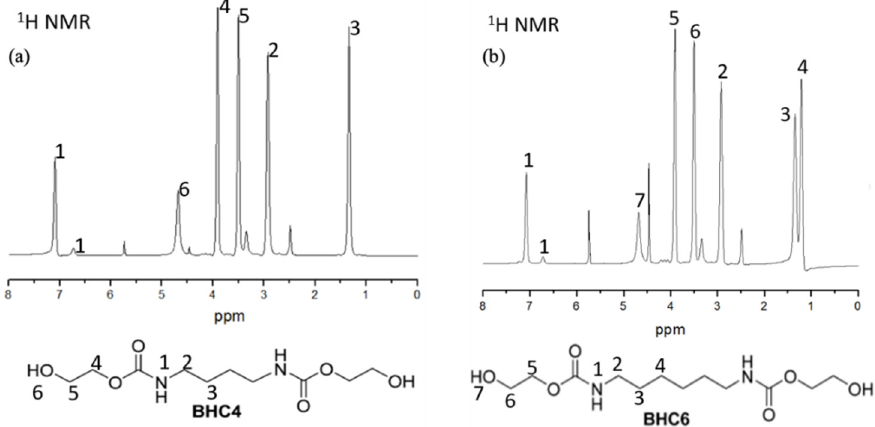
Figure 5. 1 H spectra of ( a ) BHC4 and ( b )